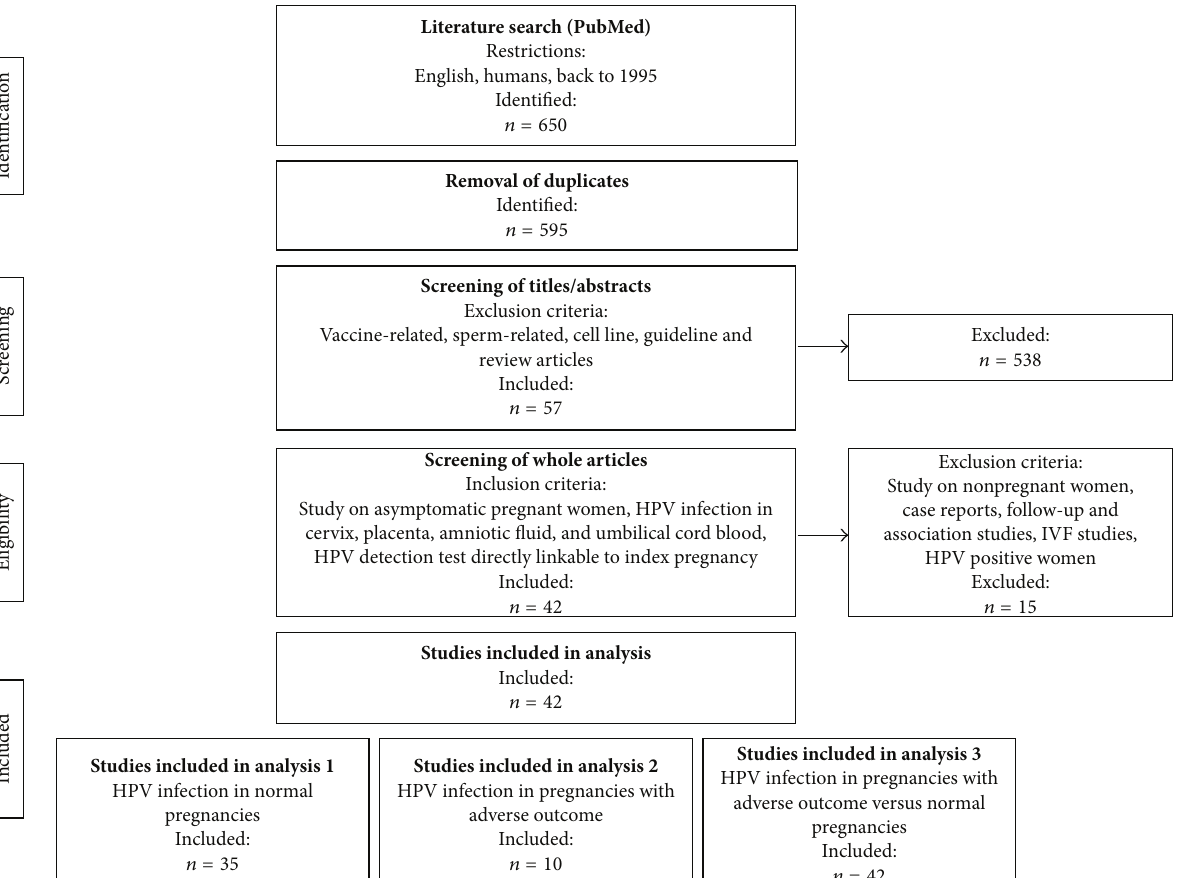
Figure 1: Flow diagram of literature search. The flow diagram shows the search in the PubMed database. A supplementary search in the Embase database was conducted in the same way and resulted in three additional articles for data extraction and quantitative